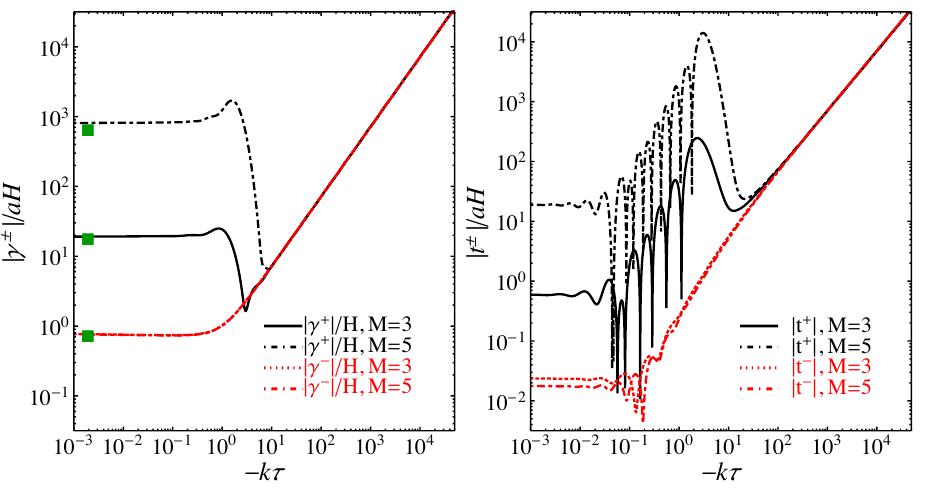
Figure 7 . Evolution of tensor (cid:13)uctuations in Higgsed Gauge-(cid:13)ation. The parameters are chosen as (cid:15) = 0 : 01 and (cid:13) = 5. The green squares show the approximate late-time result as computed in section